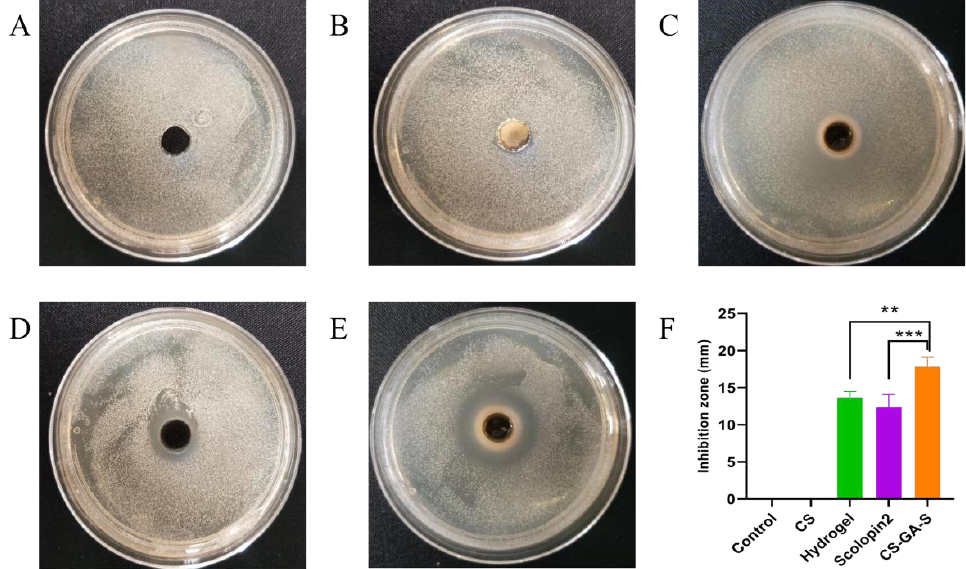
Figure 7. The antimicrobial efficacy of the hydrogel. ( A ) Model group, ( B ) CS group, ( C ) hydrogel group, ( D ) scolopin2 group, ( E ) multifunctional hydrogel (CS-GA-S) group, and ( F ) the size inhibition zone of all groups. ** represents p < 0.005, *** represents p < 0.0005.